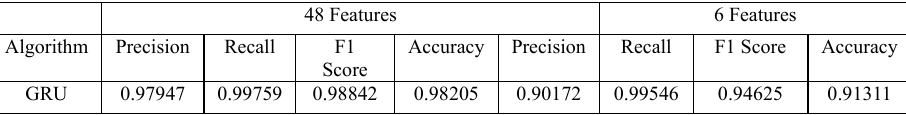
Table 1. Attack detection